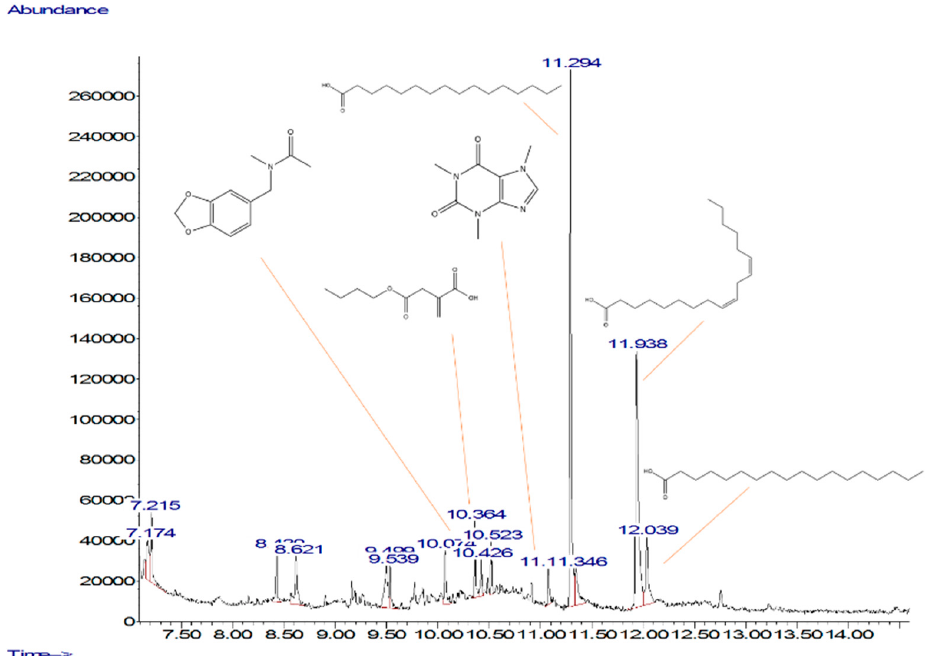
Figure A4. GC-MS chromatogram from MAW–SCG.